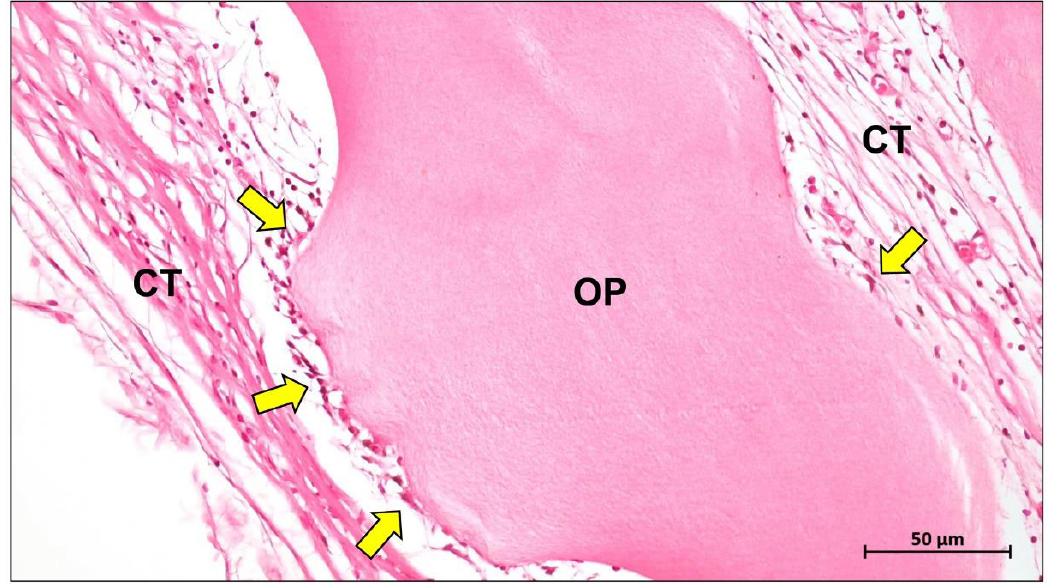
Figure 5. Representative histological image showing the tissue reaction to the ribose crosslinked barrier membrane Ossix Plus (OP) within the subcutaneous connective tissue (CT) at day 60 post implantationem. Yellow arrows = macrophages (HE staining, 200× magnification, scalebar = 50 µm).